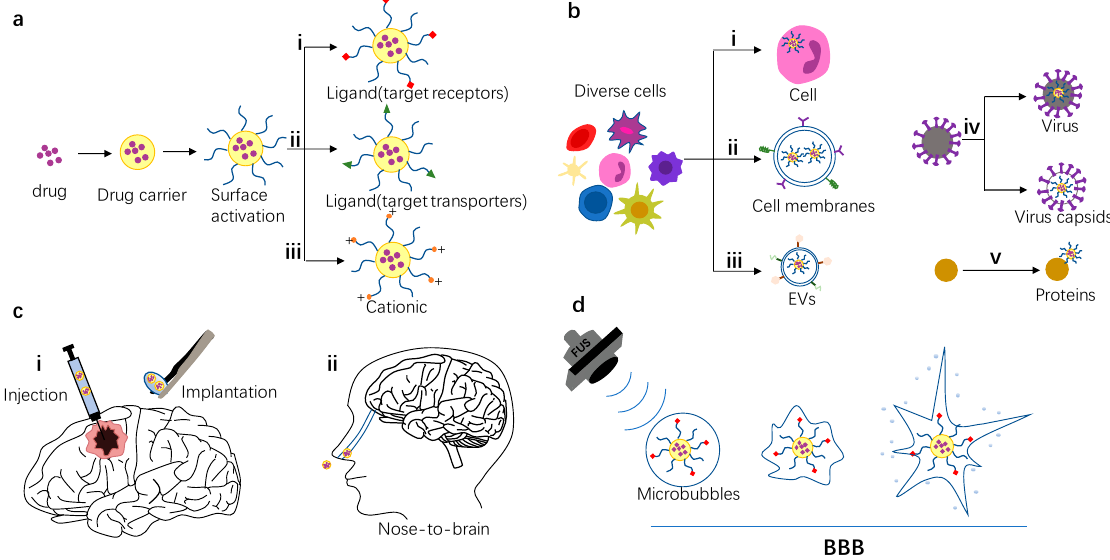
Figure 3. Schematic of strategy of nano drug carrier entering the brain. ( a ) Cross the BBB by surface modification. (i) Schematic of a nanomedicine carrier modified with ligands targeting receptors. (ii) Schematic of a nanomedicine carrier modified with ligands targeting transporters. (iii) Schematic of a nanomedicine carrier modified with cationic. ( b ) Biomimetic nano delivery system that can cheat the BBB. (i) Schematic of cells that can pass directly through the BBB, shown here as a neutrophil. (ii) Schematic of drug carrier coated with cell membrane. (iii) Schematic of extracellular vesicle drug delivery system. (iv) Schematic of virus nano drug delivery system. (v) Schematic of protein-based drug delivery system ( c ) Bypass the BBB by an unconventional route of administration. (i) Schematic of local administration mode, which can be realized by injection or surgical implantation. (ii) Schematic of nose-to-brain administration mode. ( d ) Schematic of temporary destruction of the blood–brain barrier by ultrasound combined with microbubbles.